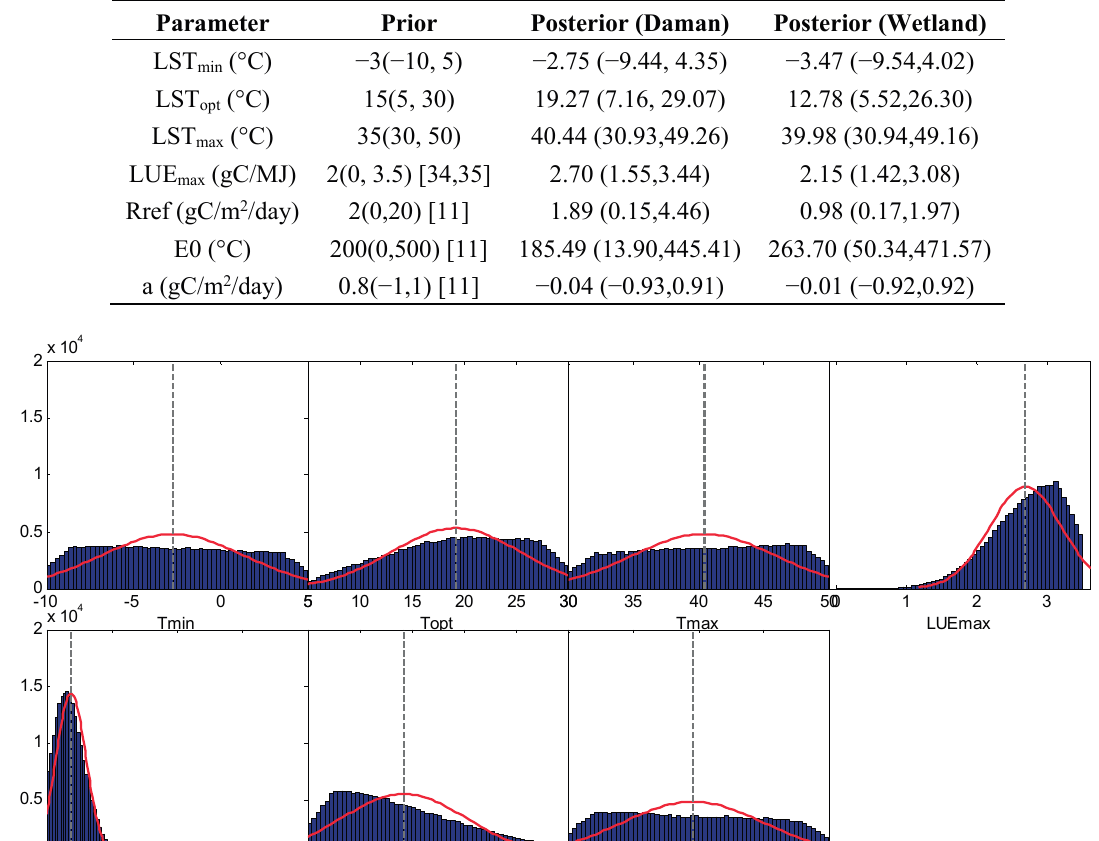
Table 2. Prior distribution (initial value and range) and posterior distribution (mean value and 95% confidence interval) of the parameters of the RS-CFLUX model at the Daman superstation (Daman) and Zhangye wetland station (Wetland).